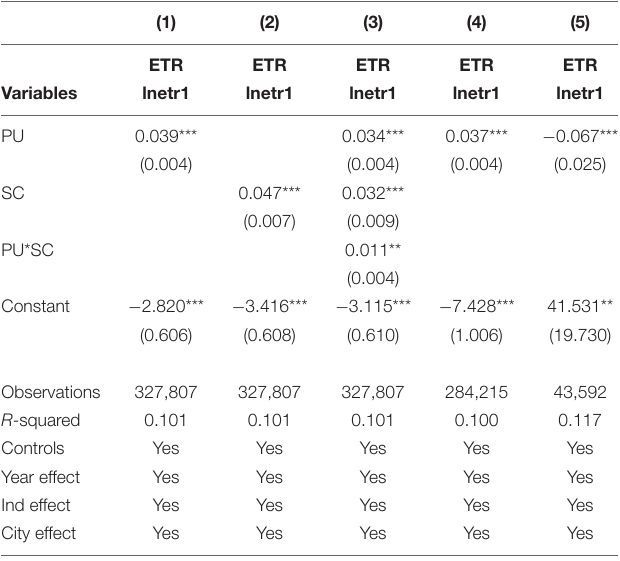
TABLE 8 | Results of regression analysis for the restricted sample interval from 1998 to